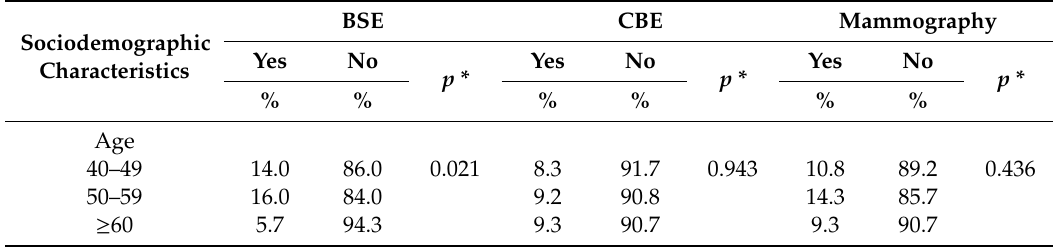
Table 3. Breast cancer screening behaviors in the participants according to sociodemographic